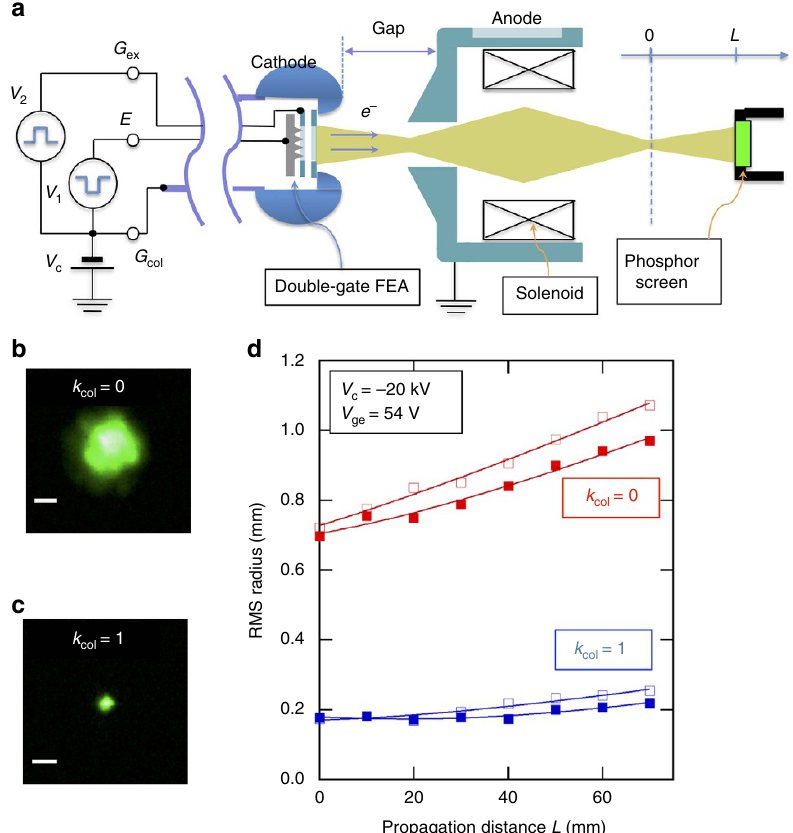
Figure 3 | Measurement of intrinsic emittance. ( a ) Schematic diagram of DC gun test setup. ( b , c ) Focussed beam image of the uncollimated ( k col ¼ 0) and collimated ( k col ¼ 1) beam at V ge ¼ 54V and the cathode potential of (cid:2) 20kV. The scale bars show 1mm. ( d ) Variation of the r.m.s. radius with the propagation distance L from the focal position ( L ¼ 0) for the uncollimated ( k col ¼ 0, red) and the collimated ( k col ¼ 0, blue) beams. The curves show the fitting results (see text). Filled and empty signs denote the radius in the horizontal and vertical directions, respectively. The solenoid current equal to 0.6 A and 0.65A were applied for the beam focussing on the uncollimated beam and the collimated beam,